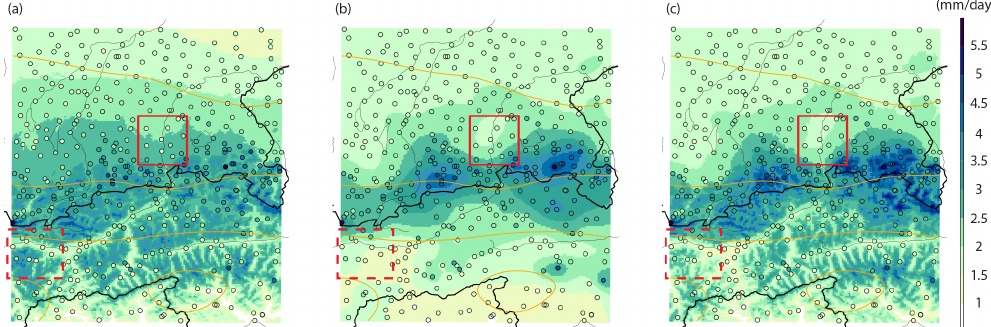
Figure 4. Distribution of DJF long-term mean precipitation (mm per day) as estimated by (a) a multi-linear regression using elevation and gradients at three spatial scales (75, 25 and 1km, LM9eg) as predictors, (b) ordinary kriging (no topographic predictors), (c) kriging with external drift using the same predictors an in (a) . Color-filled circles represent observations at rain-gauge stations. Red squares denote areas mentioned in the text. The topography is depicted with orange lines (spacing 500m).